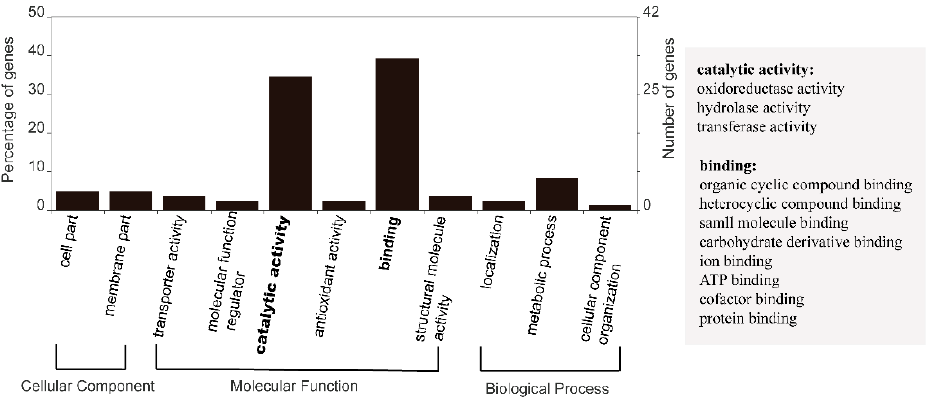
Figure 1. Core genes GO annotation category. Core genes were defined as genes commonly detected under all four conditions: control, heat stress, P deprivation, and DOP replacement, and showed expression of ≥ 50th percentile average FPKM and low CV of ≤ 0.1.